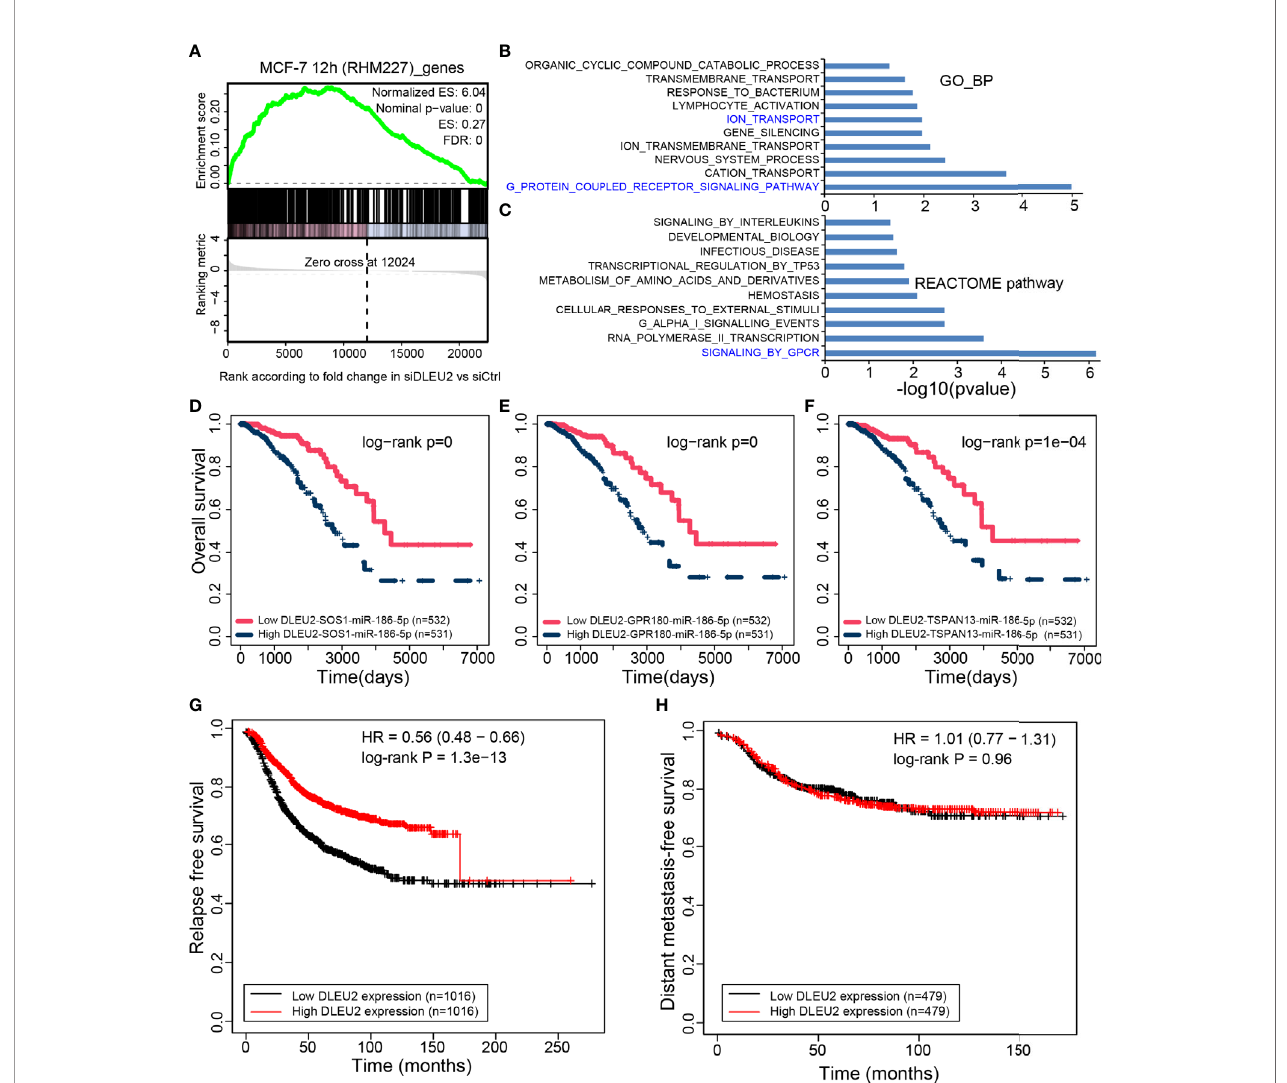
FIGURE 5 | Function inference of DLEU2 via the CCN. (A) GSEA of RNAs in MCF-7 12 h (RHM227) cell to RNAs affected by siDLEU2. The top 10 functional terms from the (B) biological process of GO (GO_BP) and (C) REACTOME pathways enriched by RNAs in the CCN of MCF-7 12 h (RHM227) cell, as determined by the hypergeometric test. The interested terms are colored in blue. DLEU2 and its ceRNAs (D) SOS1, (E) GPR180, and (F) TSPAN13 have prognostic potential for breast cancer. The relapse-free (G) and metastasis-free survival analysis (H) performed by Kaplan – Meier Plotter for